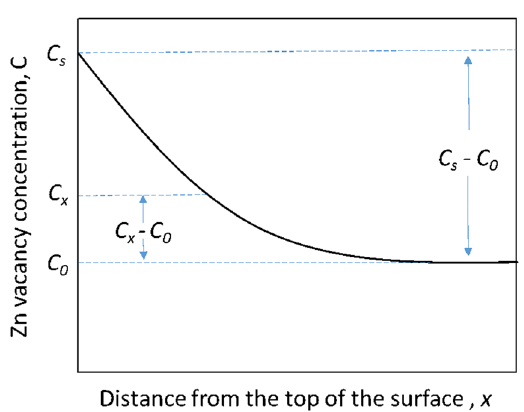
Figure 4. Demonstration of the Gaussian error function for the estimation of the diffusion coefficient.